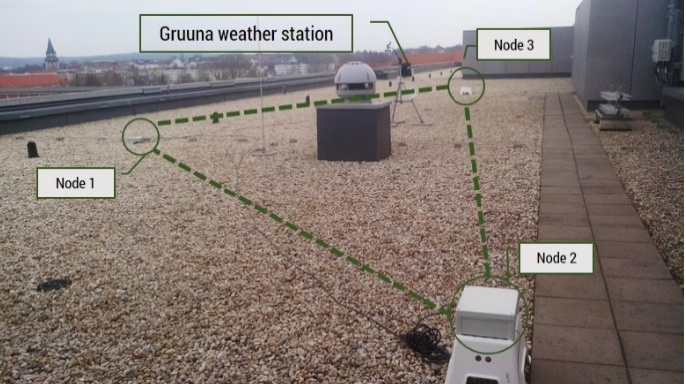
Figure 8. Investigation of weather influence in real-world (Scenario 2).